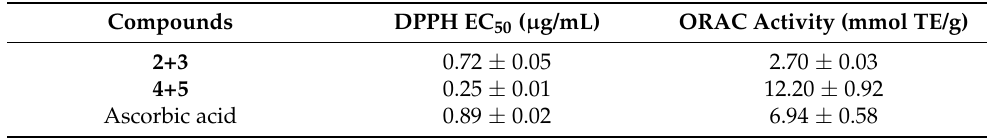
Table 6. Antioxidant activity of compounds 2 – 5 .